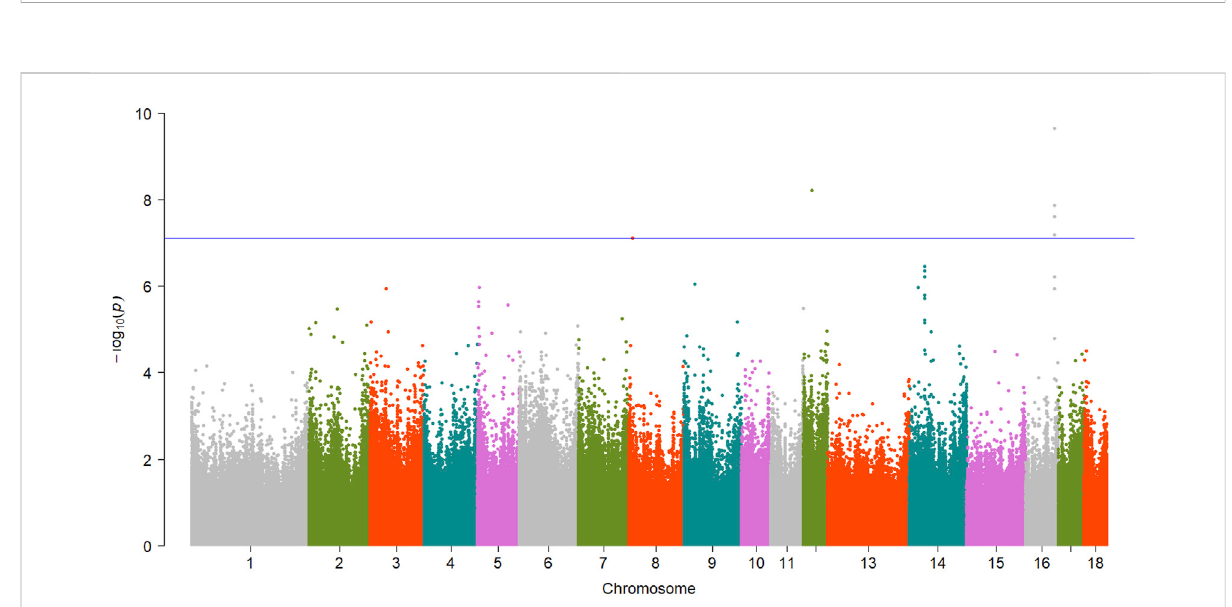
FIGURE 4 Manhattan plot showing EWAS results for L* trait. Each dot represents an CpG site and the blue line represents the